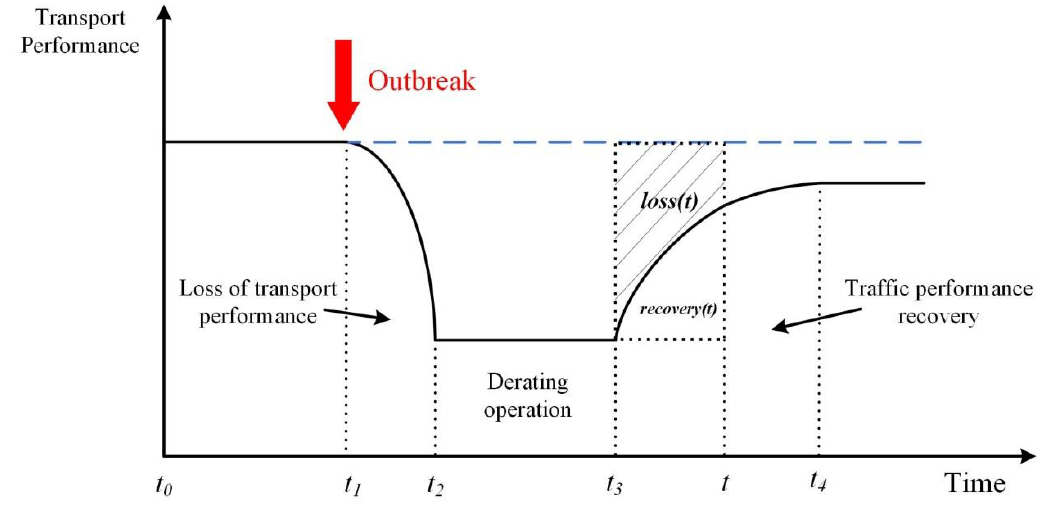
Figure 1. Functional curve of the urban transport